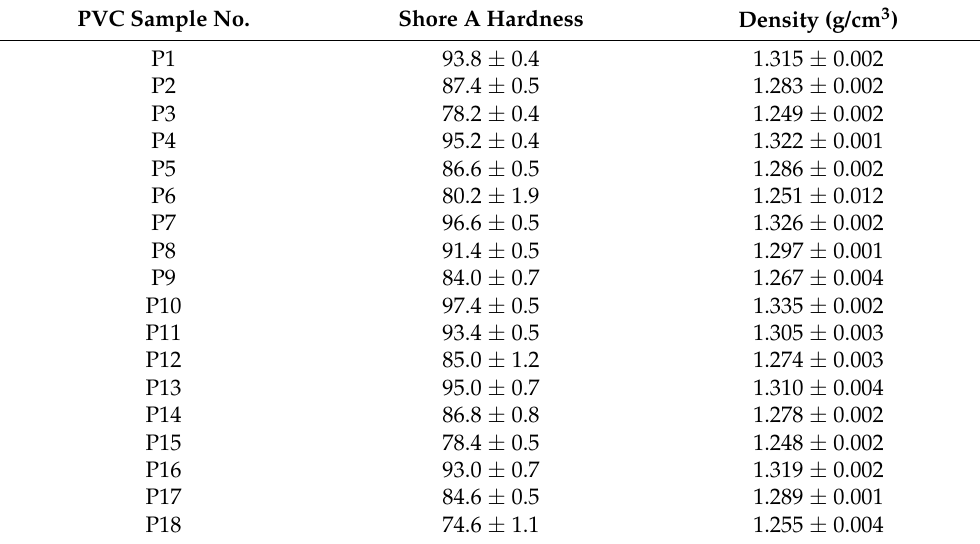
Table 7. Physical characteristic of the soft PVC samples. PVC Sample No. Shore A